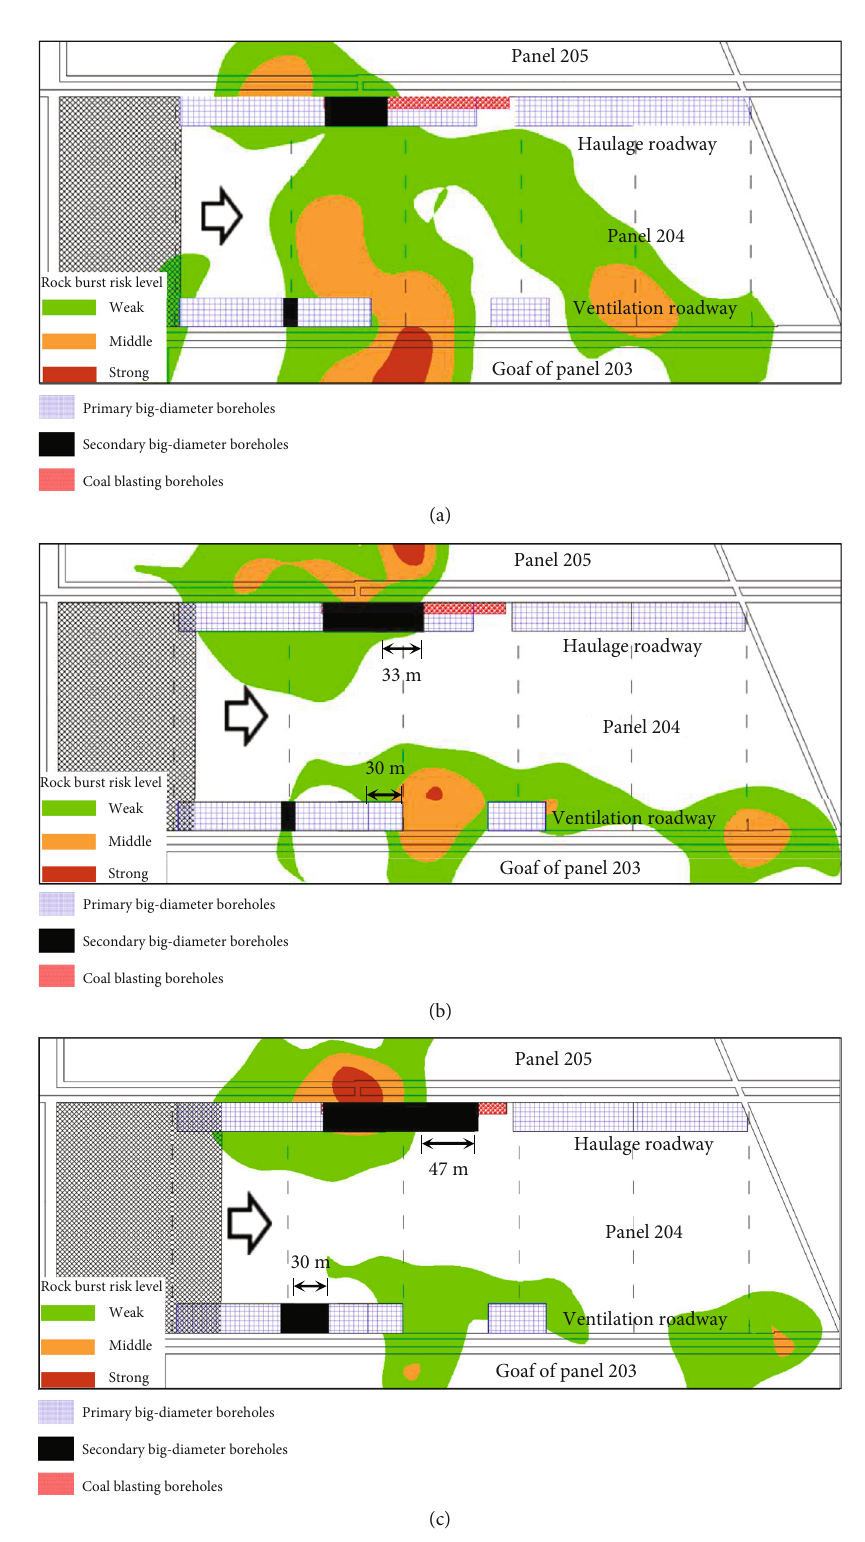
Figure 14: Rock burst risk zones and pressure-relieved zones in panel 204. (a) 30 April 2019. (b) 6 May 2019. (c) 12 May